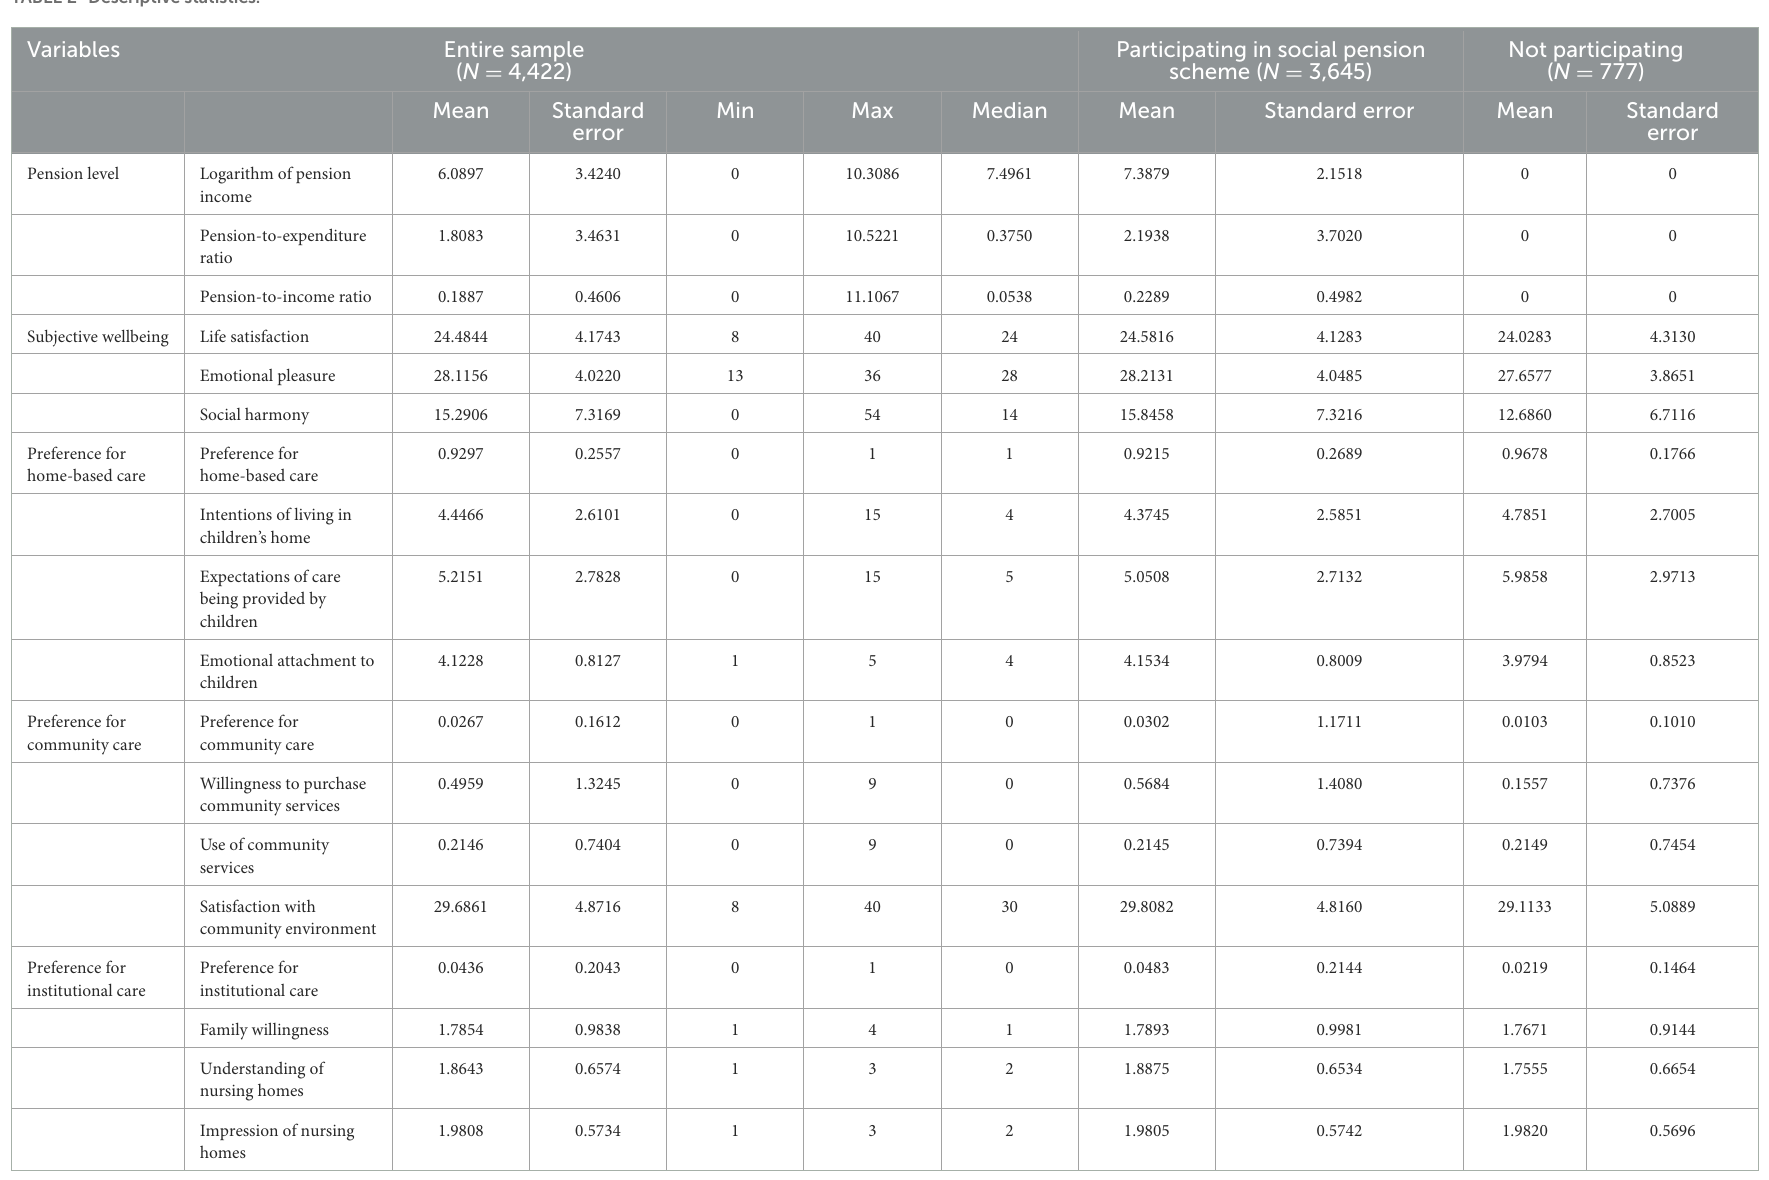
TABLE 2 Descriptive